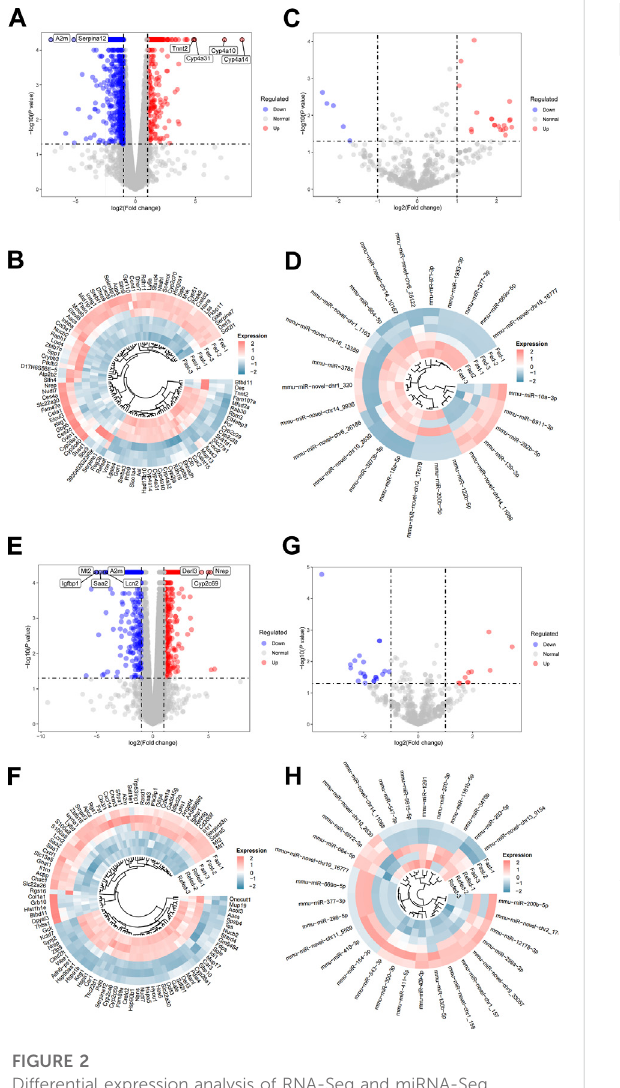
TABLE 2 Numbers of differentially expressed genes and miRNAs